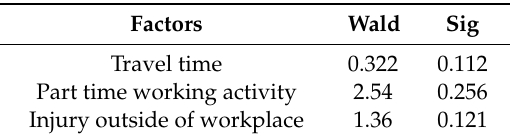
Table 2. The factors not significant for lower back